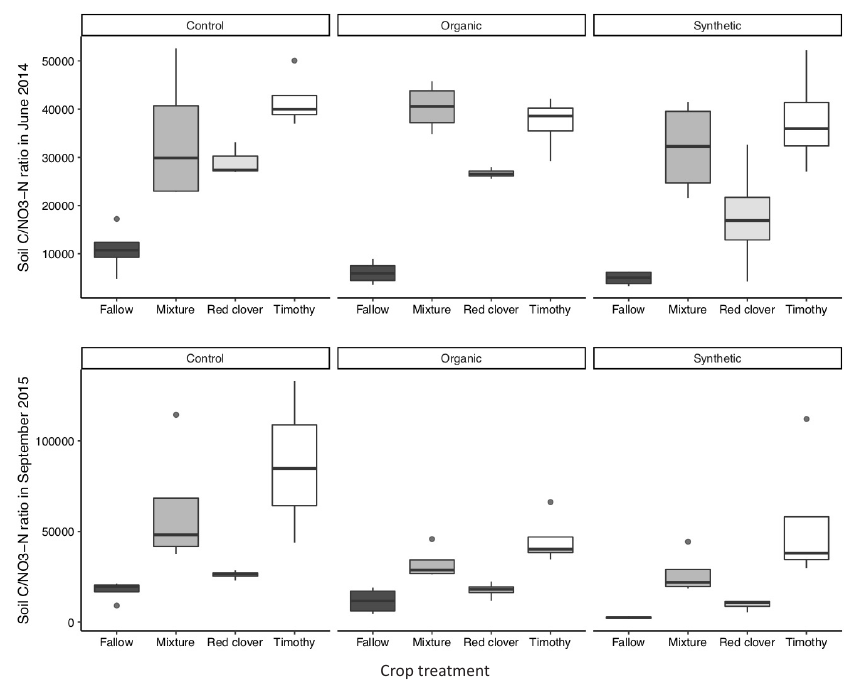
Crop Fig. 4. Box plots (n=4) of soil C/NO ratio regarding fertilizer-crop interaction in June 2014 and September 3 2015. The individual points in the figure are data points which are outside of 3/2 times of inter-quantile range.